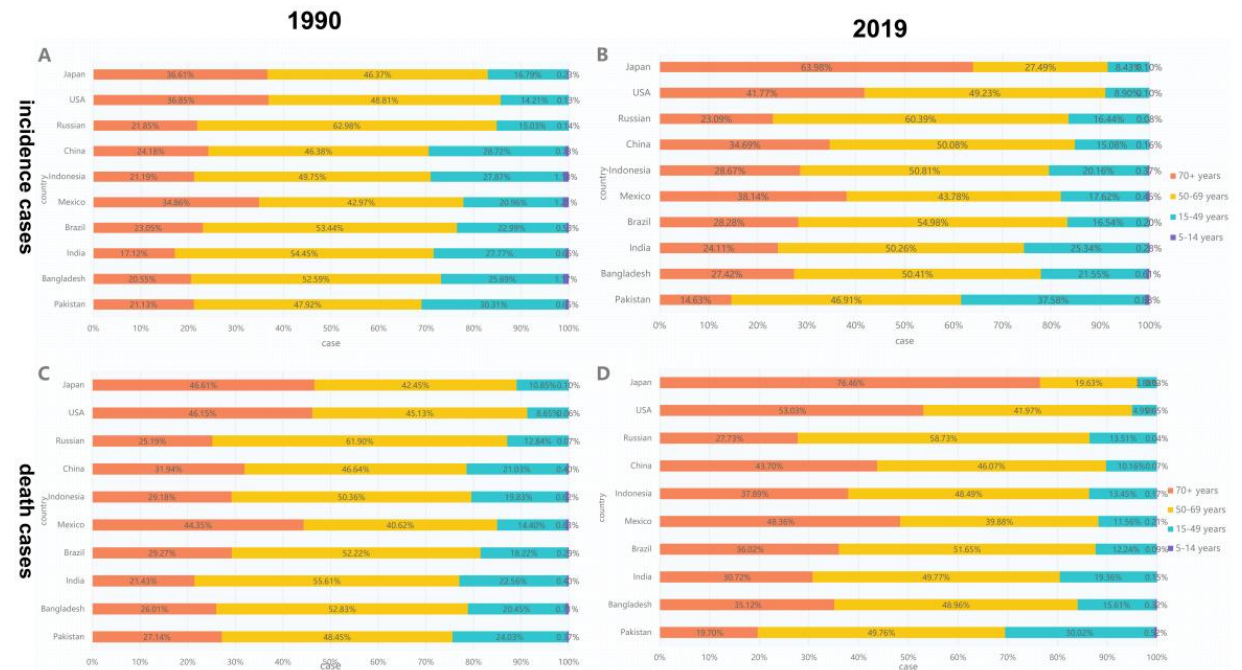
Figure 4. The correlation between SDI and oral cancer ASR (incidence ( A ), death ( B ), DALY ( C ) and SMIR ( D )) in 2019.